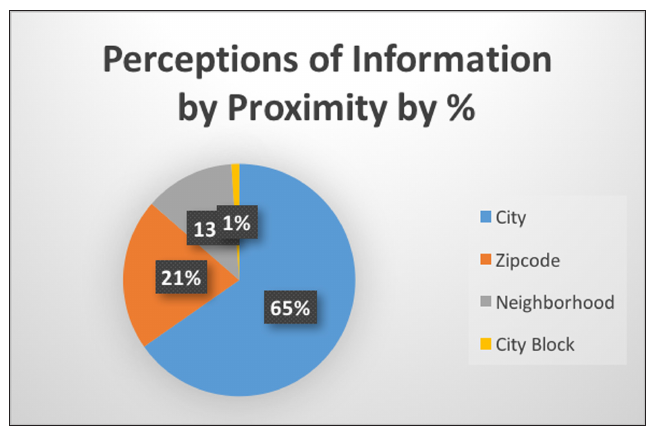
Figure 1: Perceptions of Information by Proximity.